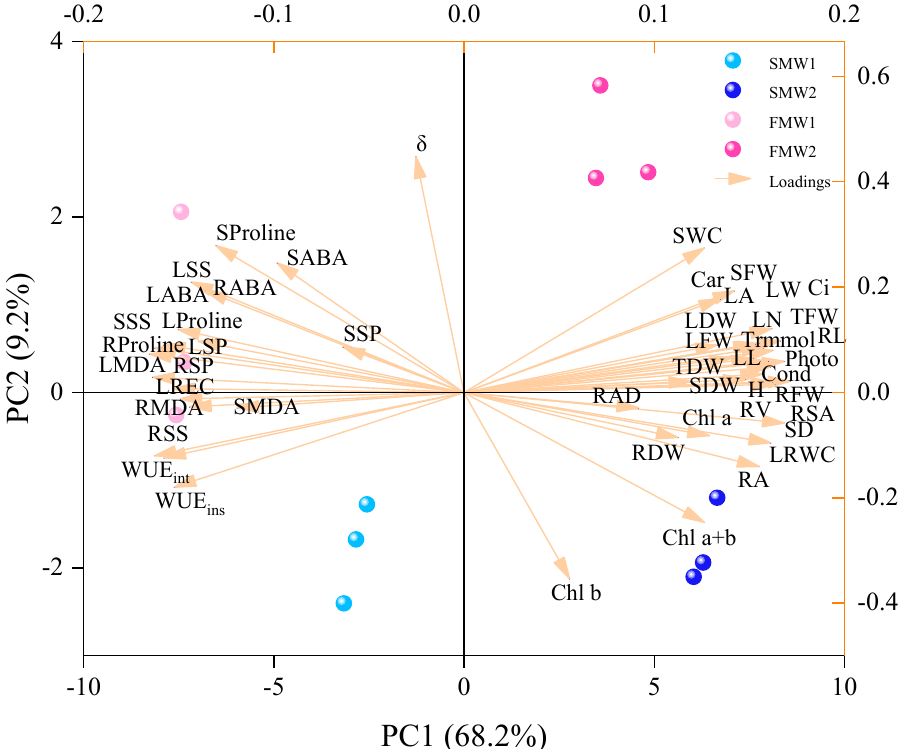
Figure 7. Biplot of the principal component analysis (PCA) of tomato indexes under different treatments. The data used in the PCA were the data from 21 days after treatment. PCn indicated the extracted principal component. SWC, soil water content; δ , fluctuation coefficient; SFW, stem fresh weight; LFW, leaf fresh weight; RFW, root fresh weight; TFW, total fresh weight; SDW, stem dry weight; LDW, leaf dry weight; RDW, root dry weight; TDW, total dry weight; H, plant height; SD, stem diameter; LN, leaf number; LL, leaf length; LW, leaf width; LA, leaf area; RL, root length; RSA, root surface area; RV, root volume; RAD, average root diameter; RA, root activity; LRWC, leaf relative water content; LREC, leaf relative electrical conductivity; Chl a, chlorophyll a content; Chl b, chlorophyll b content; Car, carotenoids content; Chl a + b, chlorophyll a and chlorophyll b contents; Photo, net photosynthetic rate; Cond, stomatal conductance; Ci, intercellular CO 2 concentration; Trmmol, transpiration rate; WUE int , intrinsic water use e ffi ciency; WUE ins , instantaneous water use e ffi ciency; SProline, stem proline content; LProline, leaf proline content; RProline, root proline content; SSP, stem soluble protein content; LSP, leaf soluble protein content;